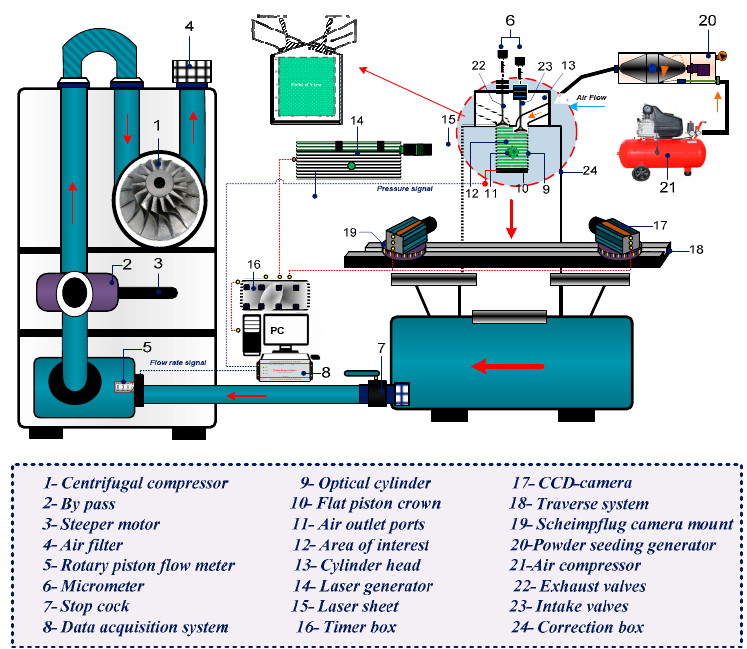
Figure 1. Experimental setup showing the field of